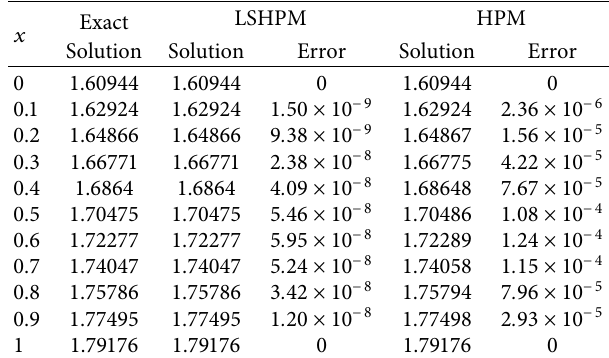
Table 8: Comparison of zeroth-order absolute error of LSHPM with HPM in Problem